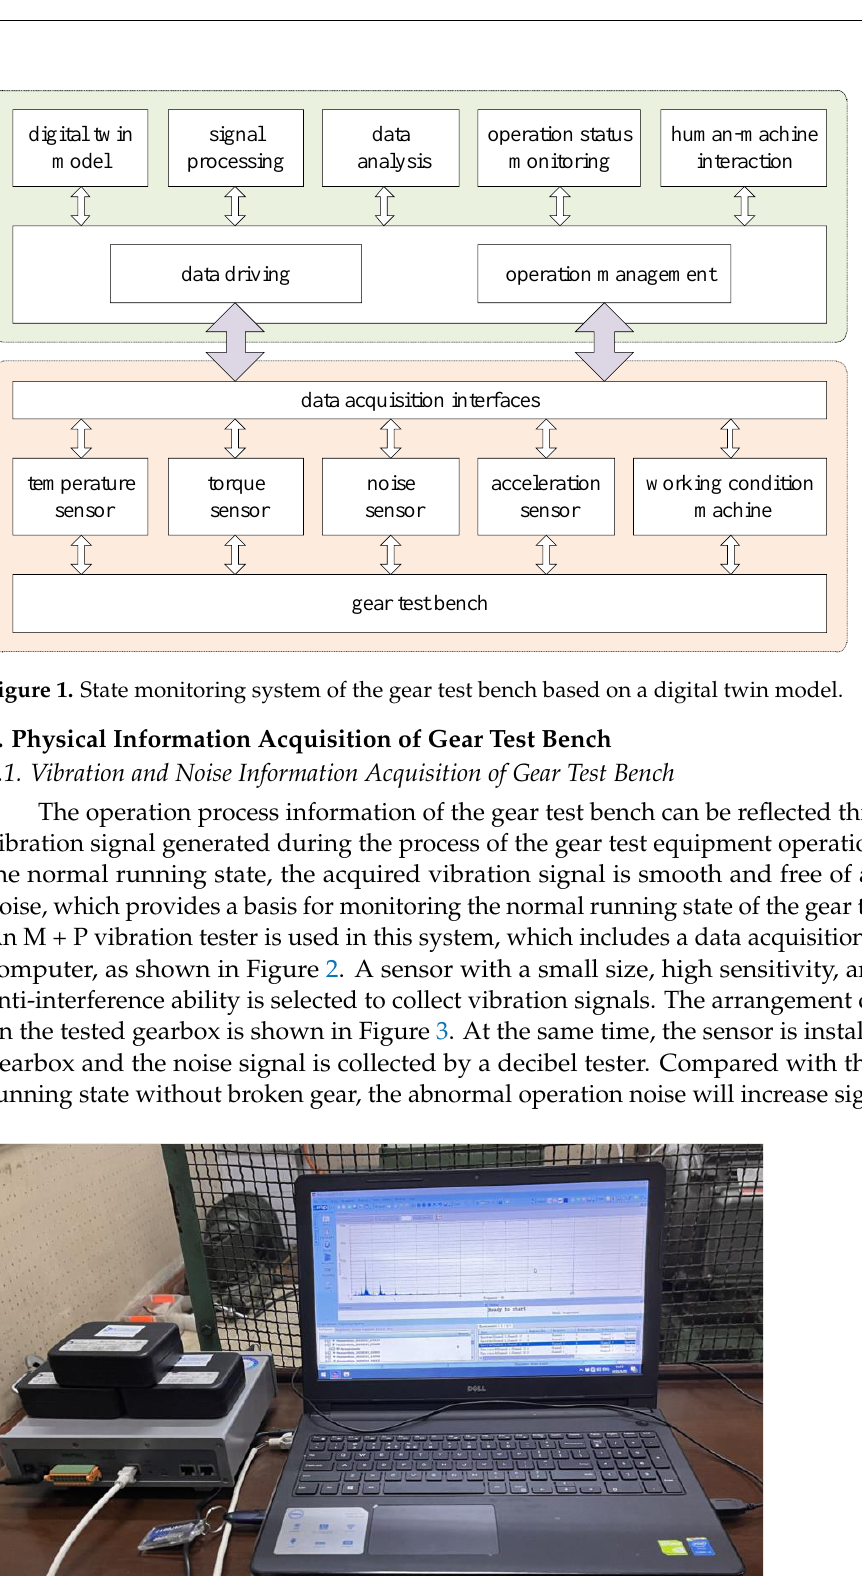
Figure 3. Arrangement of sensors on the tested gearbox. 3.2. Temperature Acquisition of Gear Test Bench During the running process of the gear test bench equipment, factors such as frictional heat and changes of laboratory temperature will result in the change of temperature of parts of the gear test bench, and the normal operation process can be disturbed. Therefore, it is necessary to measure the temperature of the gear test bench, especially the gearbox. In the gear transmission process, the generated friction heat will transfer to the gearbox and lubricating oil, causing a temperature rise of the oil. During the testing process, the lubricant temperature in the main gearbox after thermal balance shall not be higher than 80 °C, and the temperature of the main test gearbox shall not be higher than 75 °C, which is taken as the judging criteria of the gear test bench ’s normal operation. During the temperature acquisition testing, an infrared temperature gun is used to measure the temperature of the main test bevel gearbox, and the normal temperature is 54.8 °C after the thermal equilibrium. 3.3. Operation Torque Information Acquisition of Gear Test Bench The torque fluctuation of the shaft of the gear test bench reflects the changes of friction force in every direction under a normal running state. In the gear test bench, the 3 - c h a nn e l